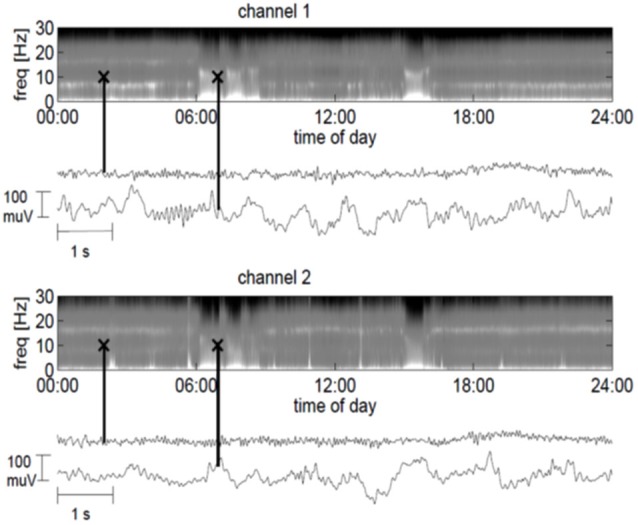
24-hour power spectra derived from the ECoG for the frontal channel 1 (top plot) and the parietal channel 2 (lower plot), where bright colors indicate strong spectral power. In addition, 10-s ECoG traces are indicated by black crosses in the spectrograms. The markers at 2:00 am in the spectrograms correspond to the traces directly below the spectrogram and depict the ECoG in a minimally slow state (channel 1) or normal state (channel 2). The markers at 7:00 am in the spectrograms correspond to the lower traces and show the ECoG in a slow wave period.